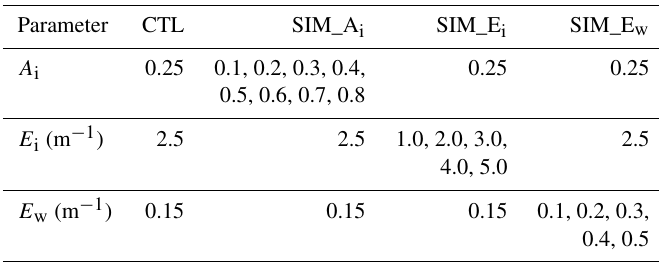
Figure 5. The simulated 3m daily average water temperature in (a) , (d) SIM_SR, (a) , (g) SIM_Precip, (b) , (e) SIM_LR, (b) , (h) SIM_U, (c) , (f) SIM_T air , and (c) , (i) SIM_q sensitivity experiments from November 2015 to June 2016 is compared with the CTL and the observation, and the change in vertical stratification is shown. The dotted line represents 3.98 ◦ C. Table 3. Numerical sensitivity simulations of parameters affecting the radiative